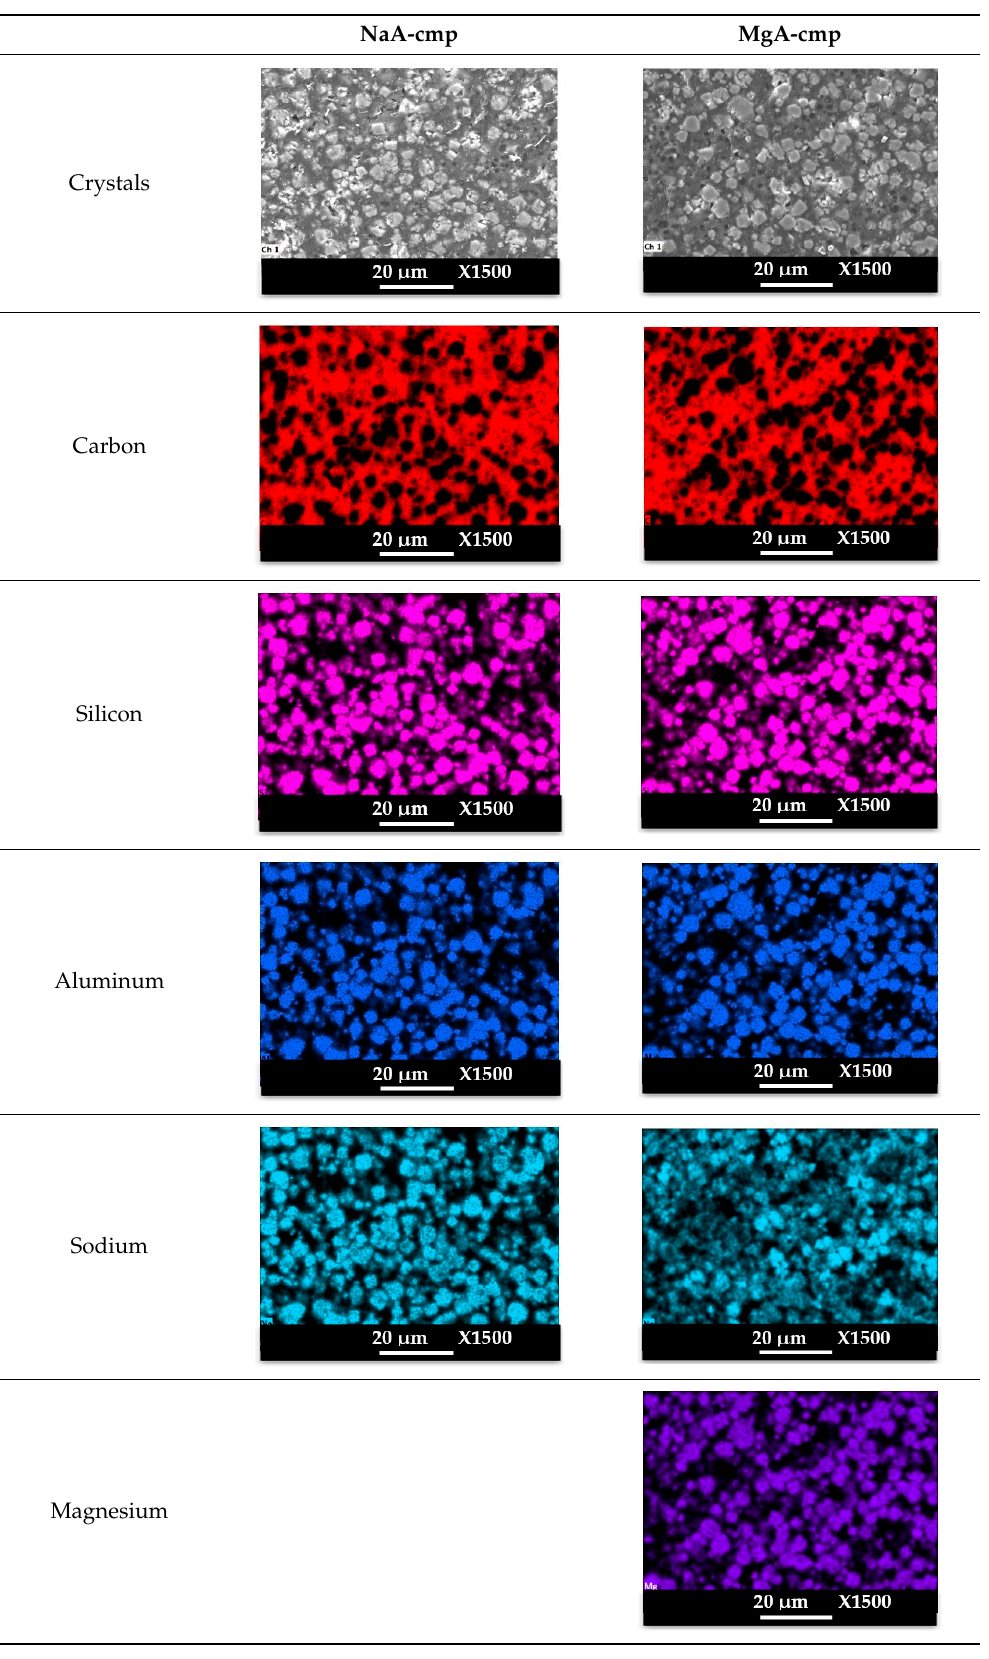
Table 5. EDX mapping of carbon, silicon, aluminum, sodium, and magnesium of the NaA-cmp and MgA-cmp (side view) samples.